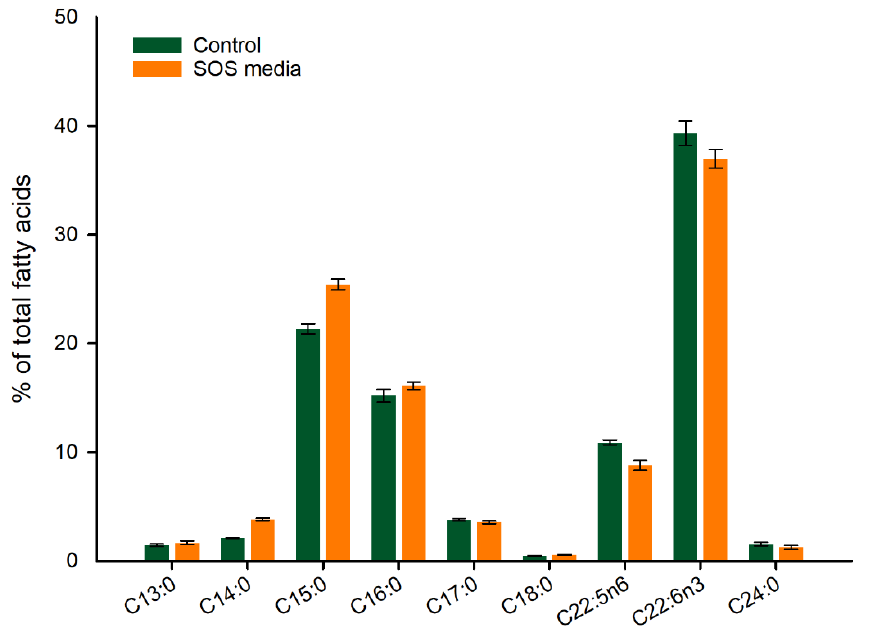
Figure 6. Fatty acid profile (expressed as % of total fatty acids) of the new SOS media compared with the control, using glucose as an organic carbon source. Values are expressed as mean (n = 3) ± SD.